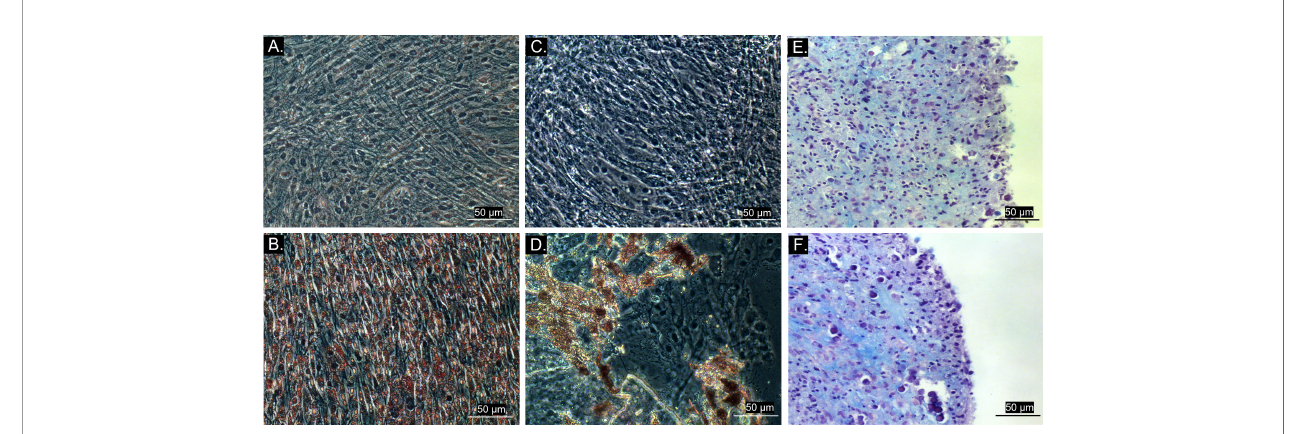
FIGURE 3 | Bright fi eld microscopy (20x objective) of MSC trilineage differentiation. (A) Control group of adipogenic differentiation; (B) Differentiated cell culture stained with Oil Red O, showing intracellular lipid droplets in red; (C) Control group of osteogenic differentiation; (D) Differentiated cell culture stained with Alizarin Red S, exhibiting extracellular hydroxyapatite crystals stained in red; (E) Control group of chondrogenic differentiation; (F) Differentiated tridimensional cell culture stained with Alcian Blue after 21 days, revealing chondral matrix sulphated proteoglycans stained in